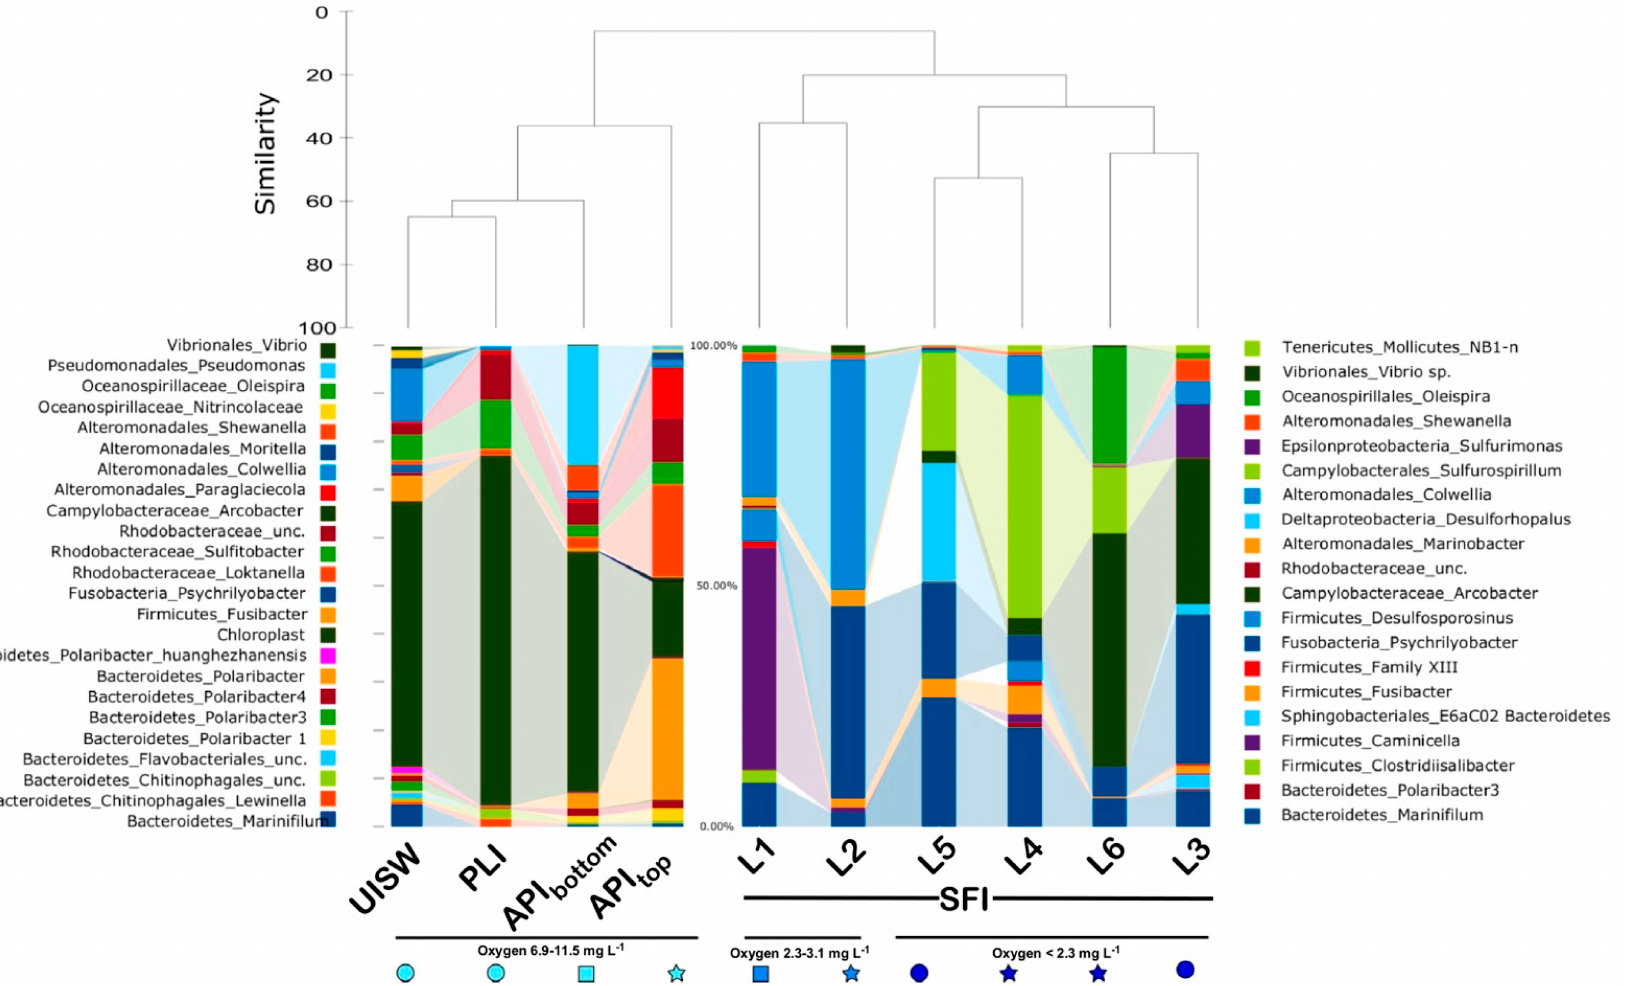
Figure 3. Histograms of bacterial genera and chloroplast-related SSU rDNA genes identified in microbial communities associated with Antarctic sea-ice. ASVs which could not be resolved at the genus level were reported with the designation ‘unc’ after the name of the nearest known parental rank. The list of the identified genera and their relative abundances is reported in Table S1. The abbreviations used are similar to those shown in Figure